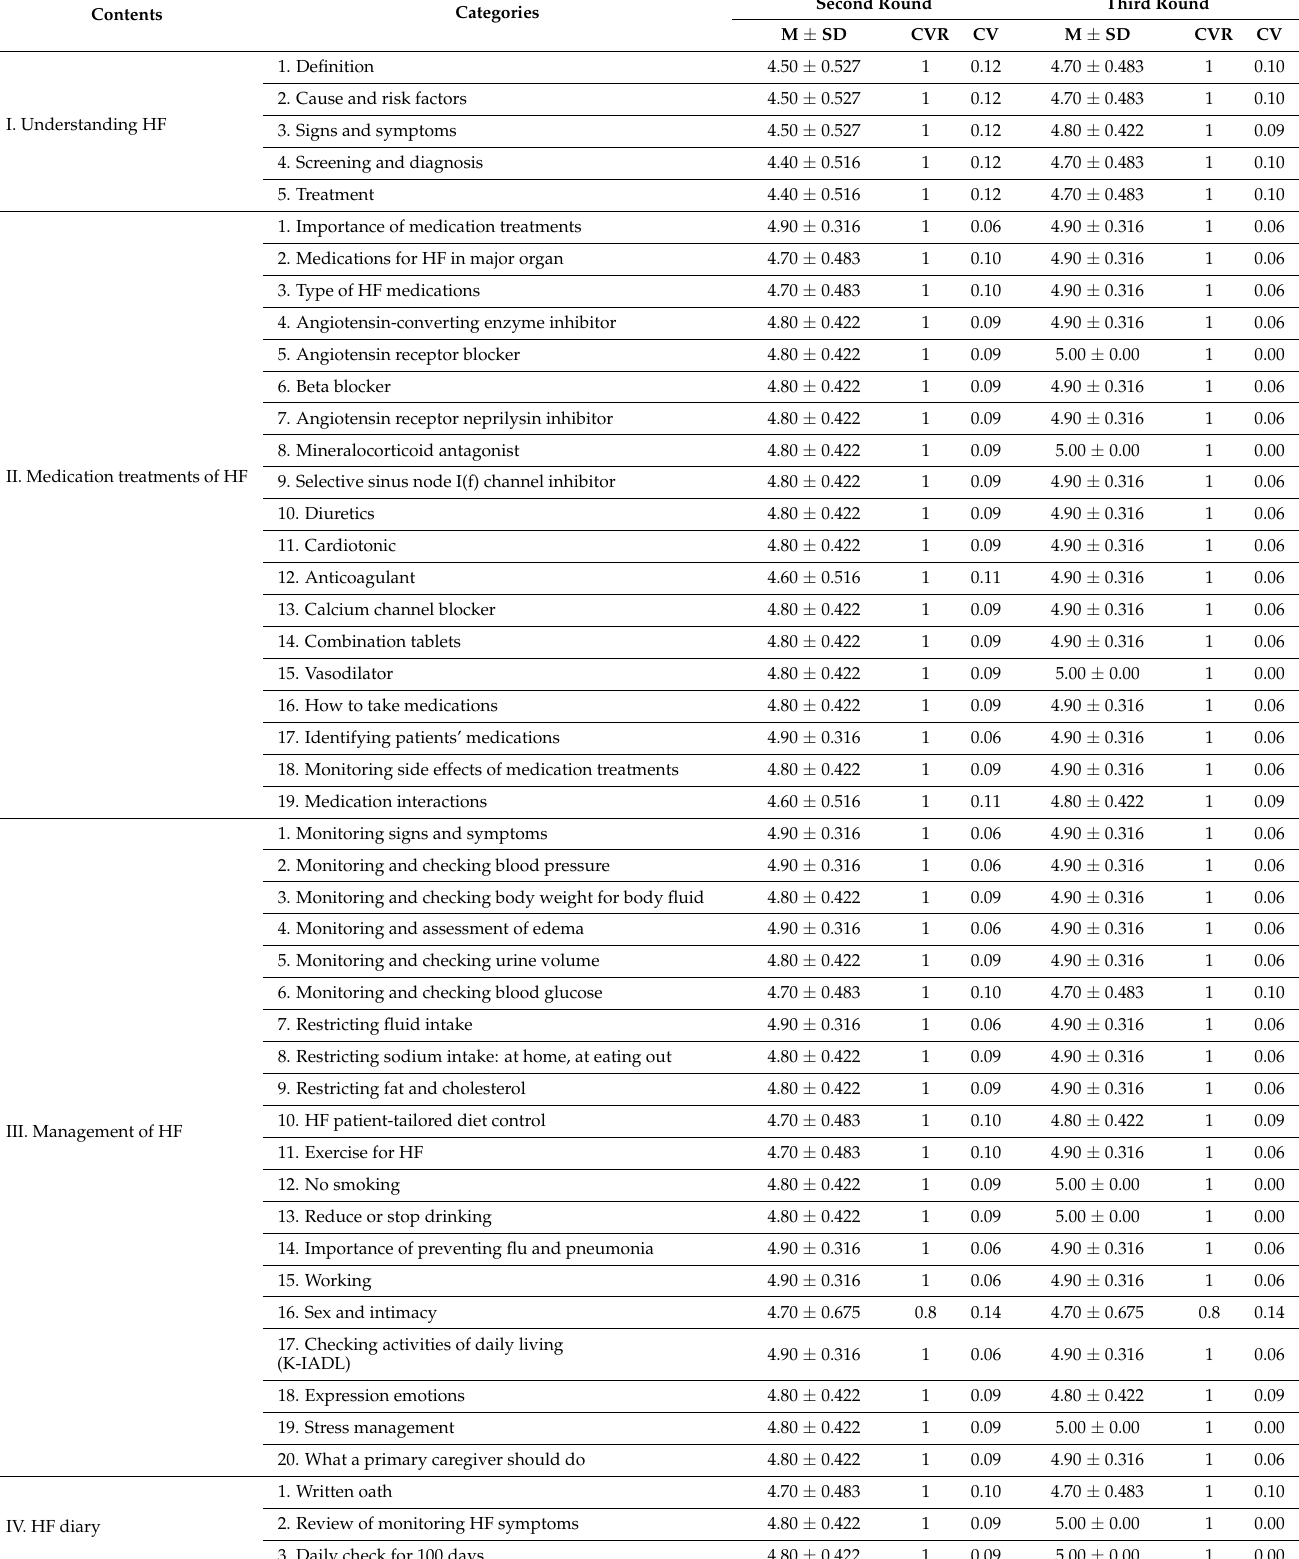
Table 2. Results of the second and third rounds of the Delphi survey (N =